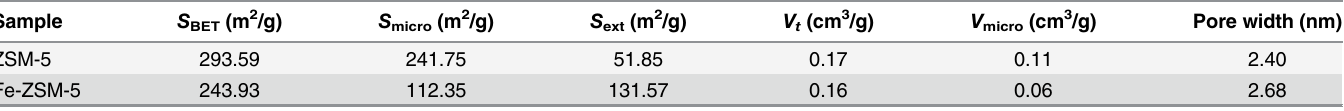
Table 2. Pore structure characteristics of the ZSM-5 support and Fe-ZSM-5 catalyst. Sample S BET (m 2